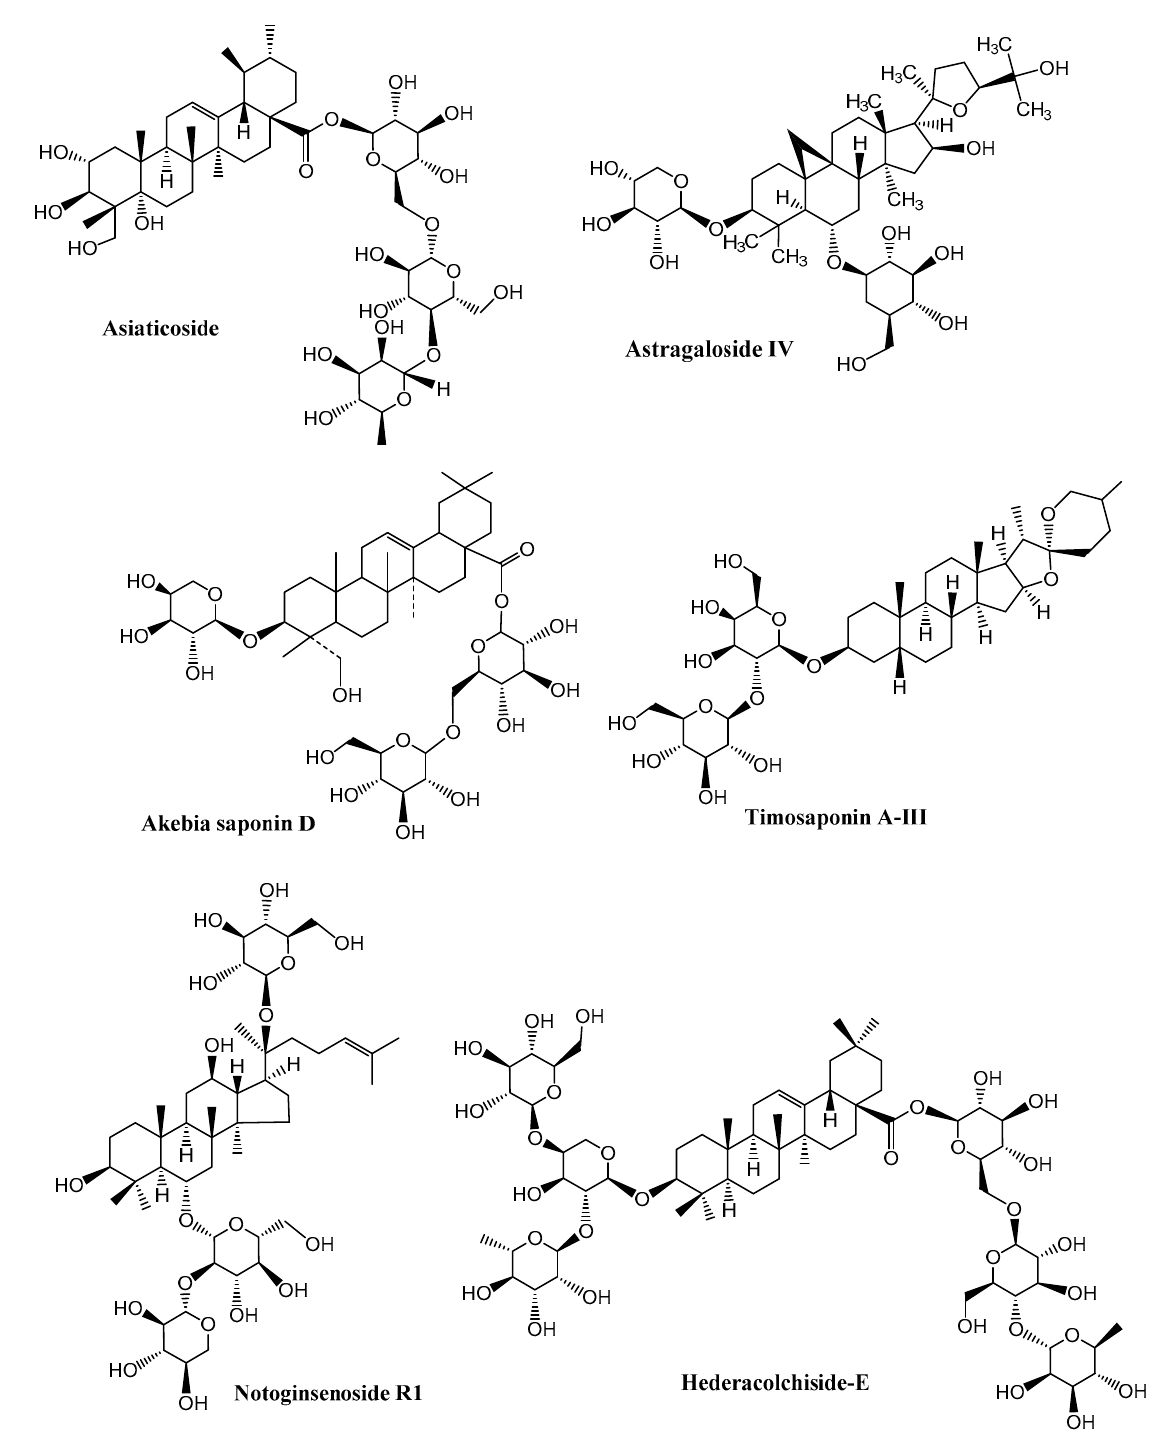
Figure 4. Neuroprotective saponins from medicinal plants. (Chemical structures were generated using ChemBioDraw ultra version 14).